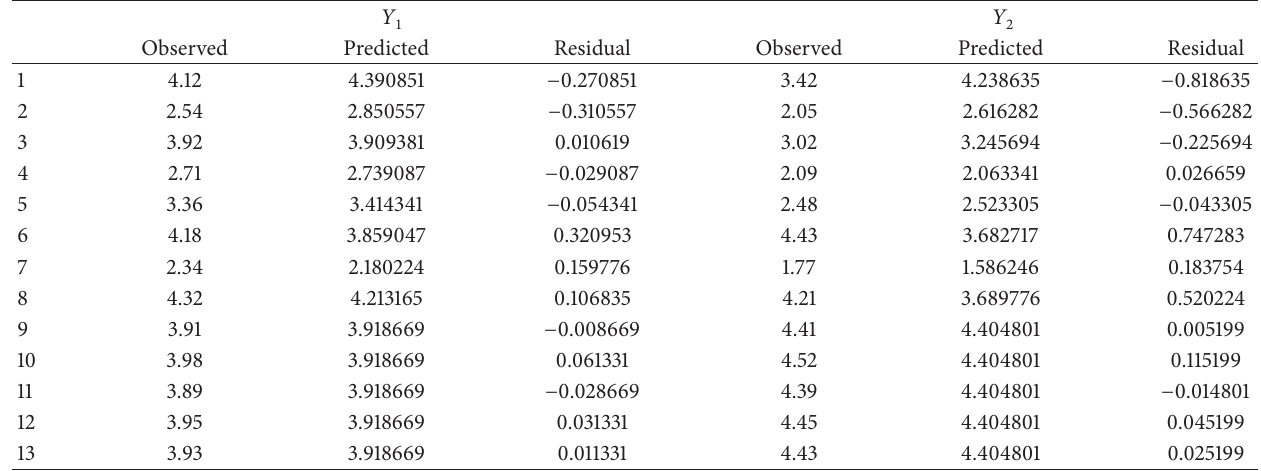
Table 5: Observed, predicted, and residual values of the two responses 𝑌 1 and 𝑌 2